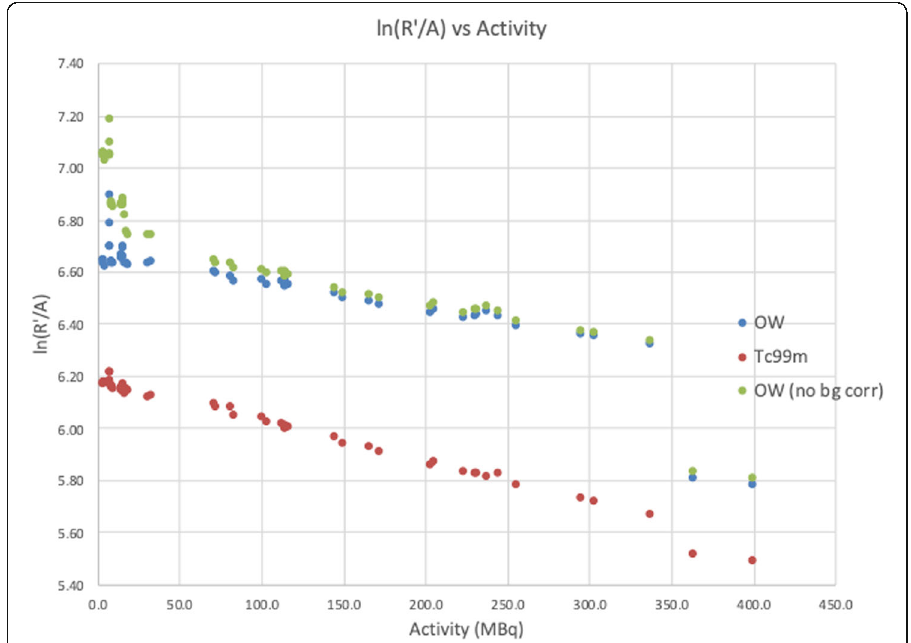
Fig. 3 Graphical dead time calculation. Plot of ln( R ′ / A ) vs. A (MBq) for the intrinsic measurement for detector 1 for the OW (blue, green) and 99m Tc (red) energy window